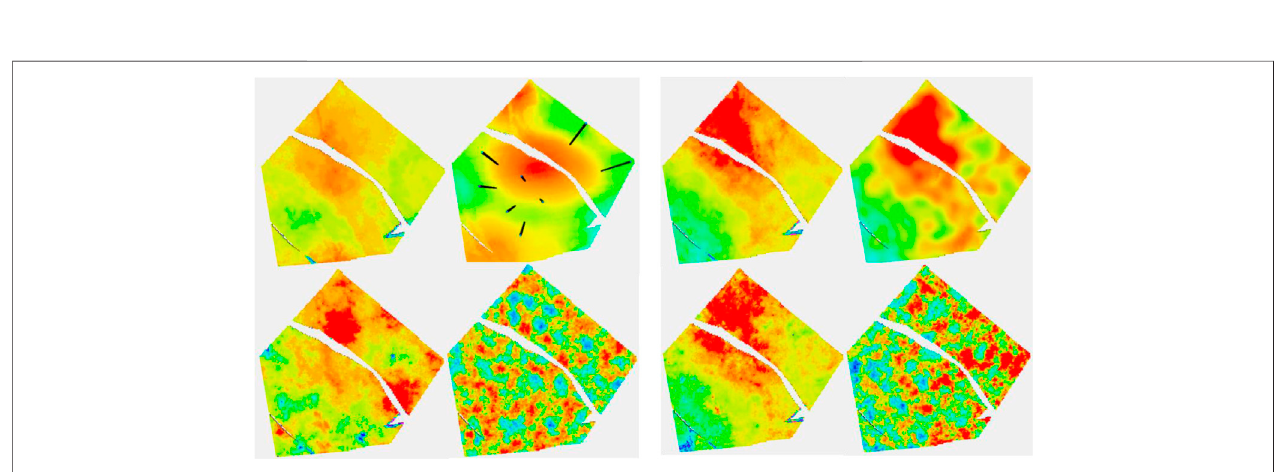
FIGURE 10 | The classic Gaussian simulations referred to in Table 1 . They differ by the trend management and the variogram used.